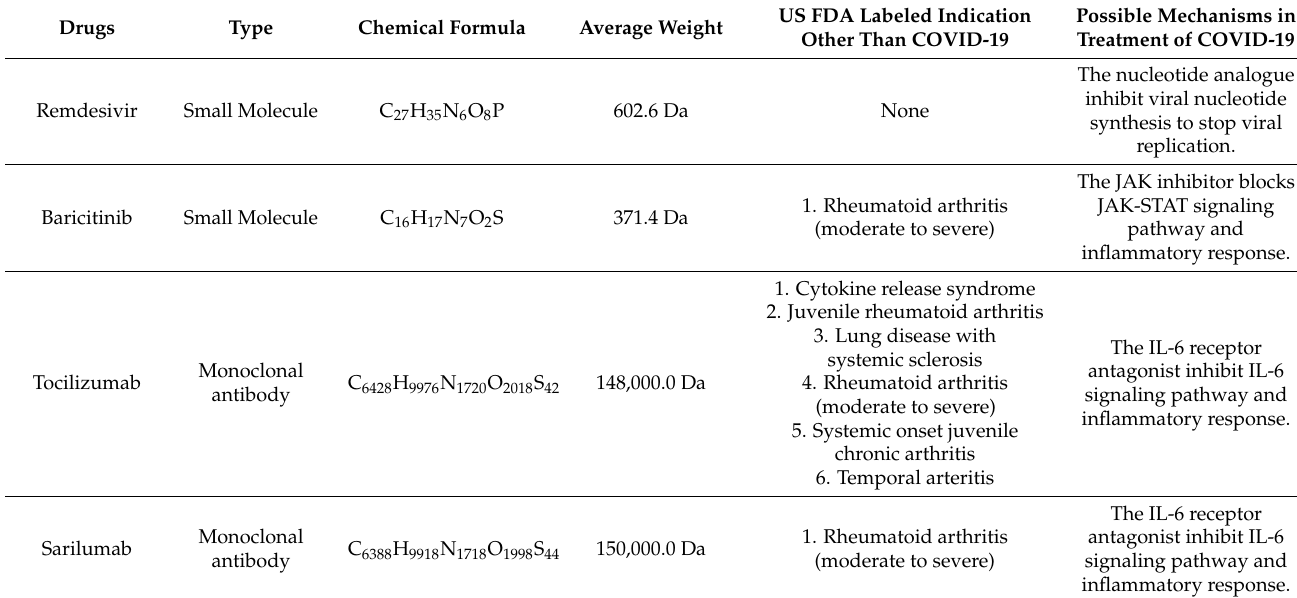
Table 1. The chemical structures and molecular properties of available drugs in moderate-to-severe COVID-19.